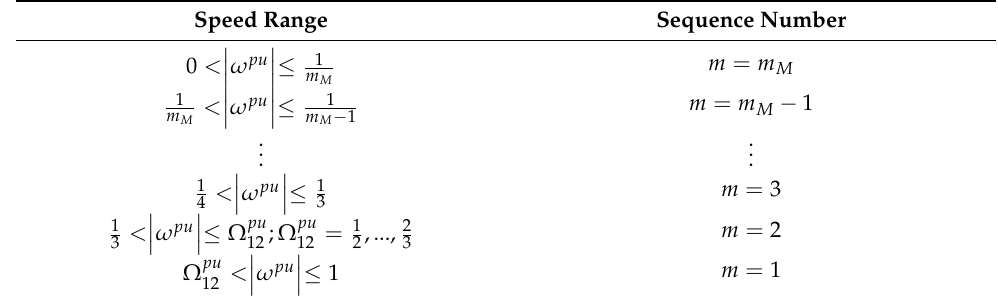
Table 2. Selection of m with respect to speed ranges.